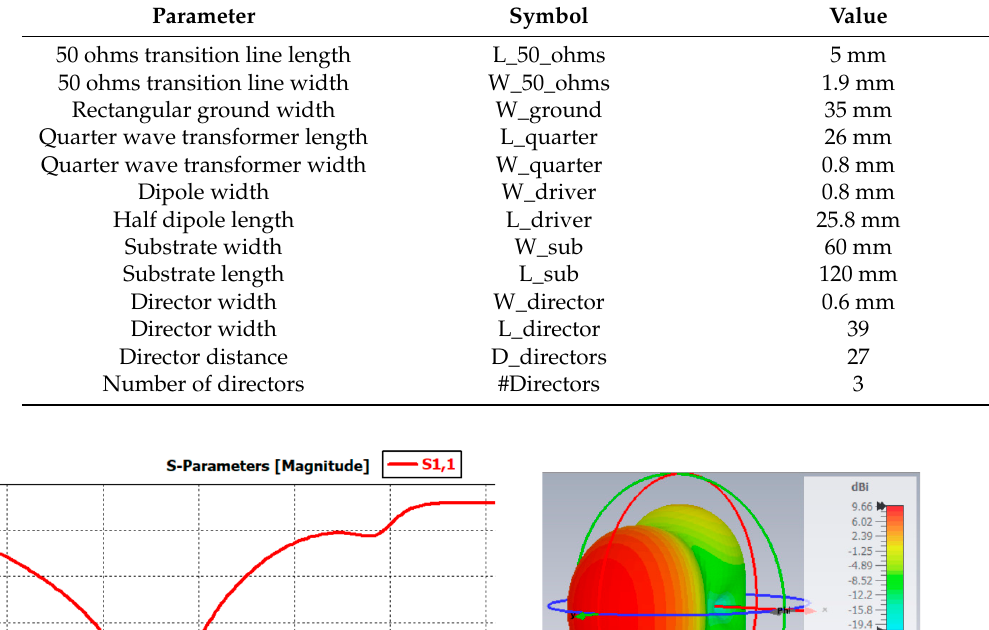
Table 4. Yagi–Uda Results.